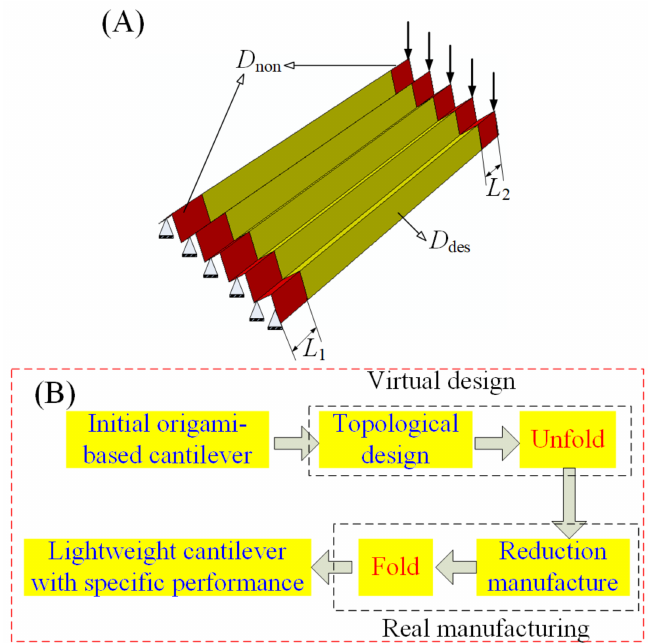
Figure 2. ( A ) The initial design and non-design domain for the origami-based cantilever; and ( B ) the proposed design and fabrication